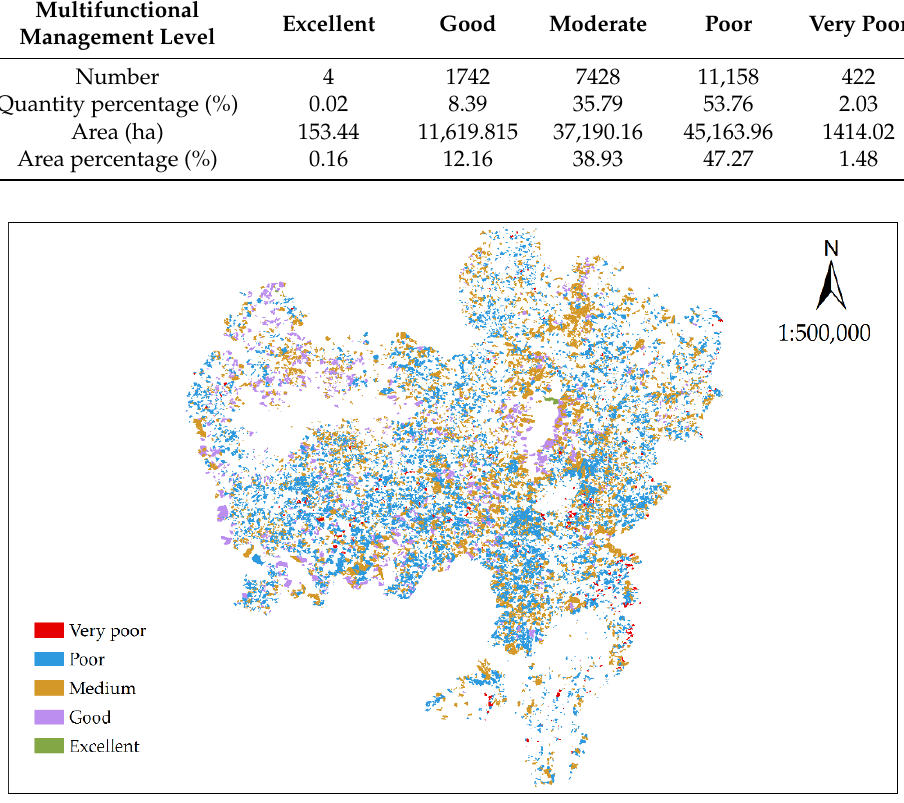
Figure 5. Spatial distribution of multifunctional management level in Rongshui County of Guangxi Zhuang Autonomous Region. Excellent, Good, Moderate, Poor and Very Poor mean multifunctional forest management level.